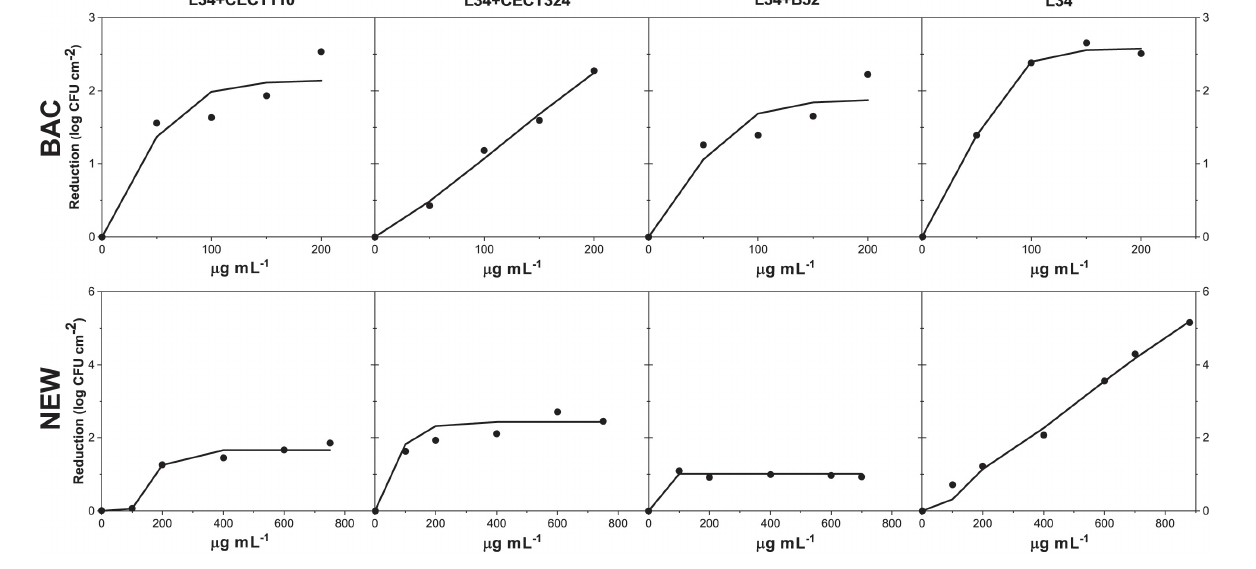
Frontiers in Microbiology |